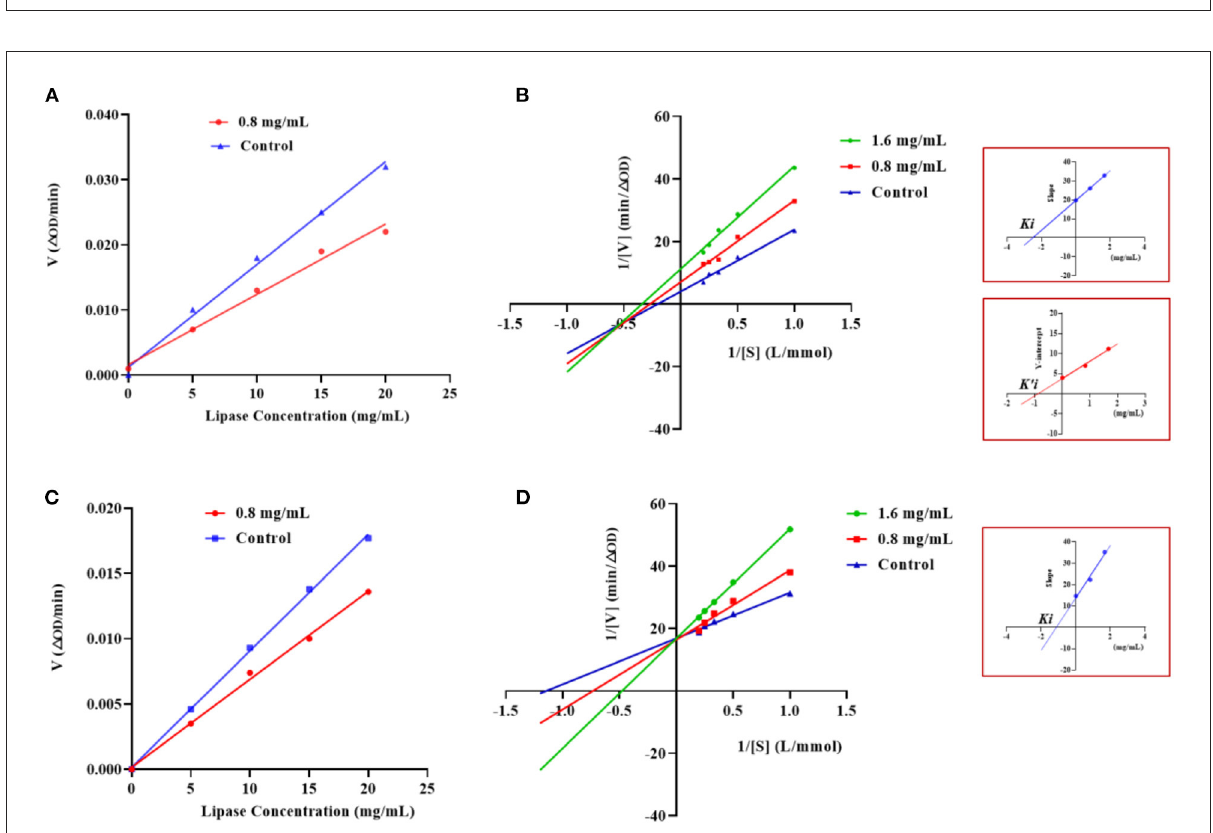
FIGURE5 Effects of different concentrations of GSPPPSG (A) and KLEGDLK (C) on the reaction rate of PL. Lineweaver–Burk plots of GSPPPSG (B) and KLEGDLK (D)